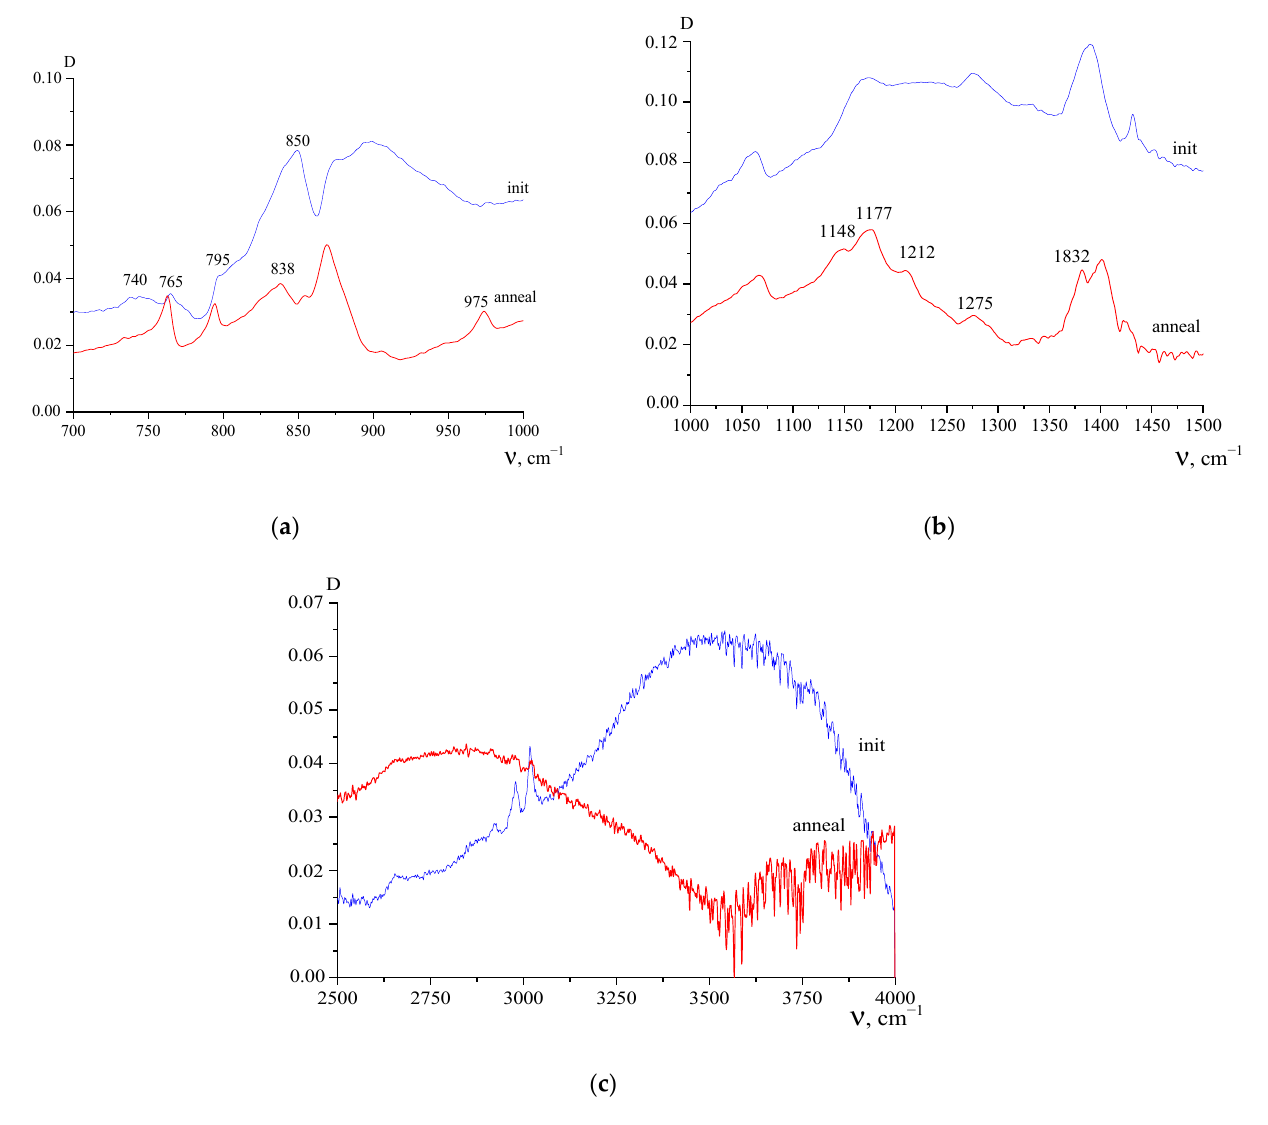
Figure 6. ATR IR absorption spectrum in the 700–1000 cm − 1 ( a ), 1000–1500 cm − 1 ( b ), and 2500–4000 cm − 1 ( c ) range for PVDF and PVDF + ITO films with ITO before (init) and after annealing (aneal). The possibility of intensification of the noted chemical interactions at the polymer– ITO interface during annealing indirectly follows from the frequency dependences of the components of the complex permittivity of three-layer capacitors, metal-polymer-ITO- metal, which are shown in Figure 7a,b. For comparison, the curves for a similar copolymer with a conductive layer of graphene-containing material [29] are shown in the graph. It can be seen that in the case of the inorganic conductive coating, two new dispersion regions arise in the material at low frequencies.